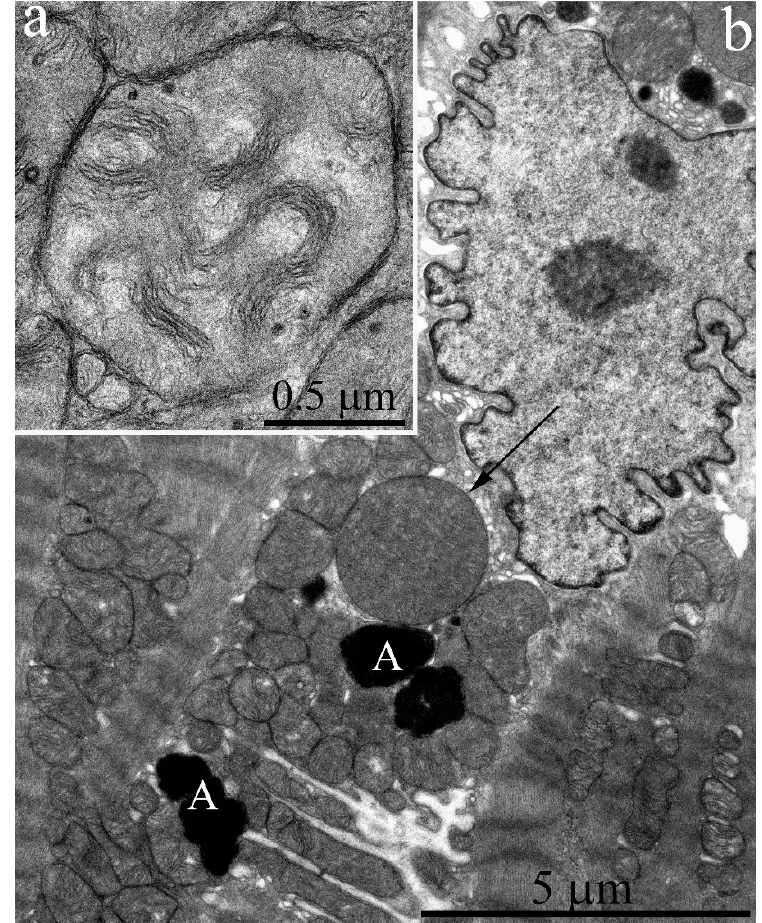
Figure 6 . Electron microscopic image of the ultrastructure of a left ventricular cardiomyocyte from an 11-year-old naked mole rat. ( a ) Ultrastructure of mitochondria from the main population. ( b ) General view at low magnification. The arrow indicates a large mitochondrion, which is shown at greater magnification in Figure 7. A—autophagosome.